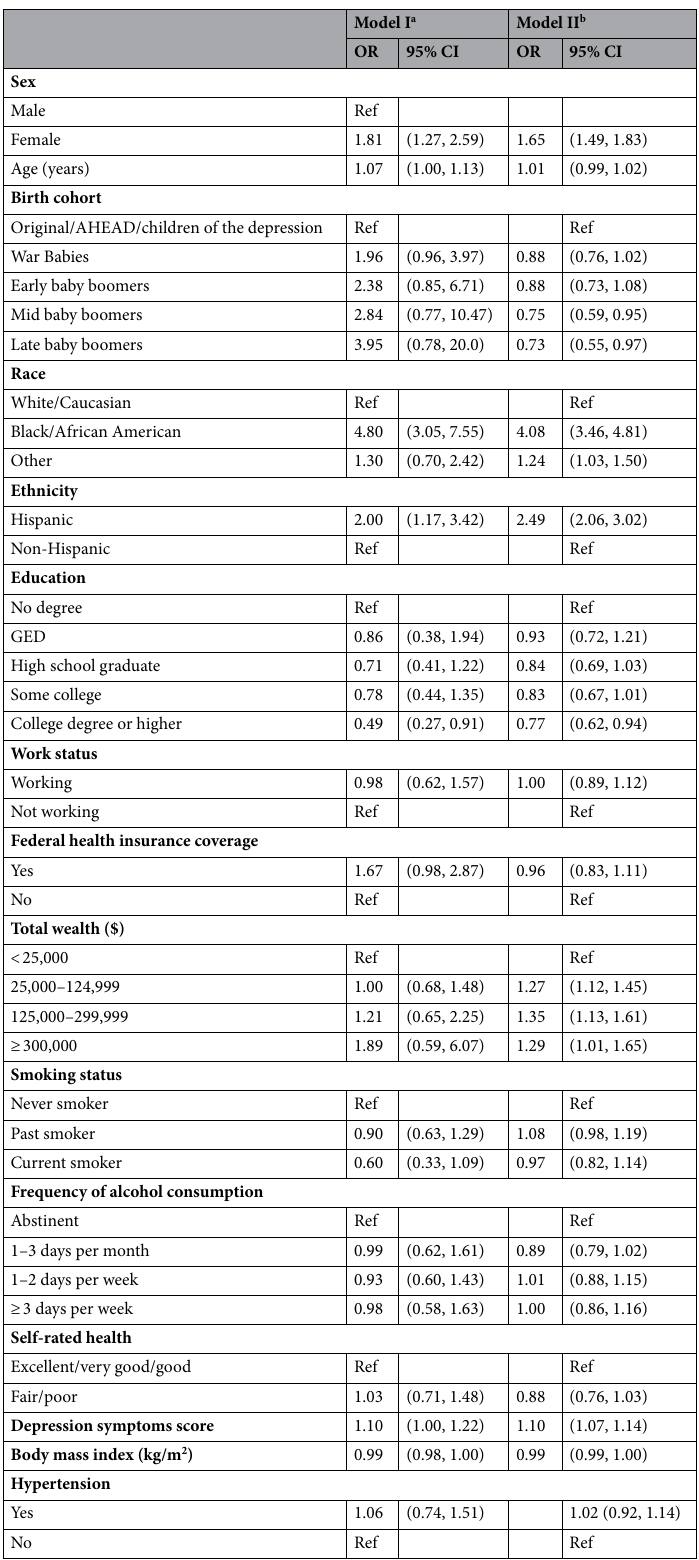
Table 2. Ordinal logistic regression and mixed effects ordinal logistic regression models for major predictors of Covid-19 level of concern—2020 Health and Retirement Study enhanced interviewing Covid-19 half- sample. AHEAD study of asset and health dynamics of the oldest old, GED general educational development. a Ordinal logistic regression model. b Mixed effects logistic regression